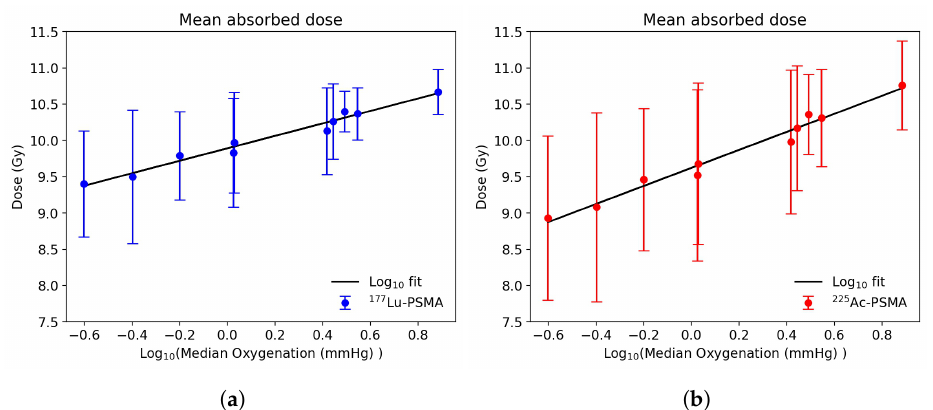
Figure 4. Relationship between the mean absorbed dose and the median oxygenation for 177 Lu- PSMA treatment ( a ) and 225 Ac-PSMA treatment ( b ). The vertical lines represent the dose standard deviation within each examined